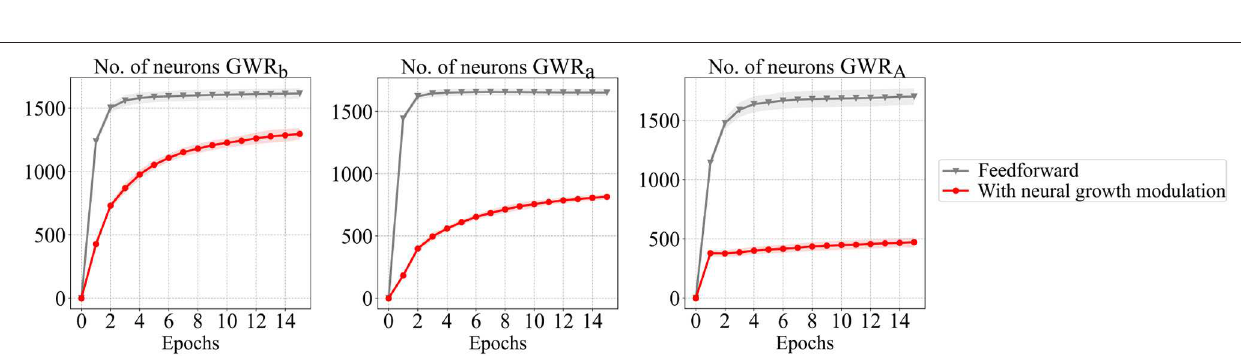
FIGURE 6 | Comparison of the classification results on the training data of CAD-120 when training is conducted only with a feedforward input stream and when using the proposed neural growth modulation (Mici, 2018). (A) The accuracy of the GWR a network which learns to classify actions, and (B) the accuracy of the GWR A network which learns to classify the activities. The results are averaged over 4-fold cross-validation experiments.